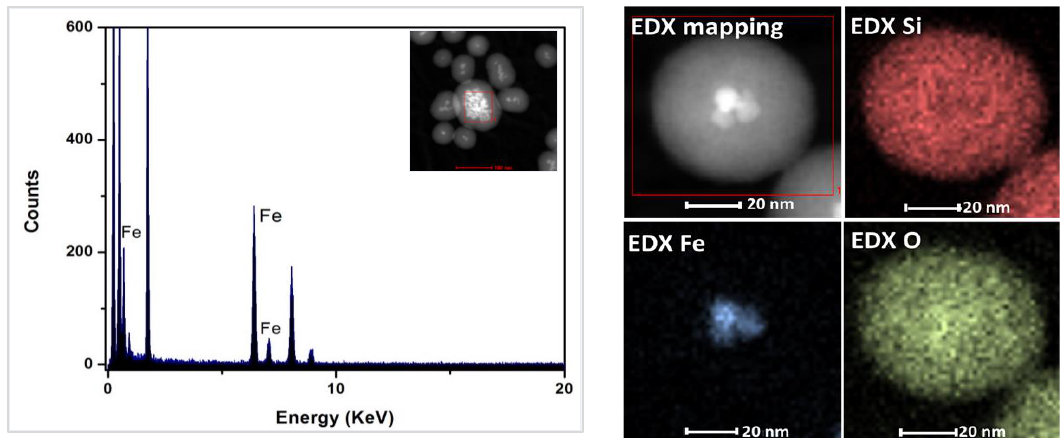
Figure 5. EDX spectroscopy (Left) and EDX mapping analysis (Right) of M-Ethylene PMO NPs.